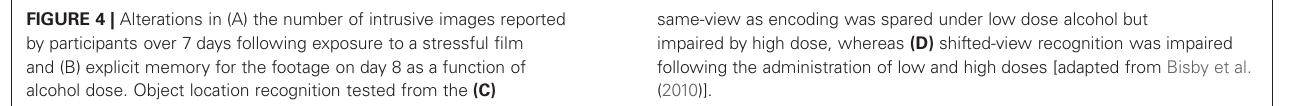
same-view as encoding was spared under low dose alcohol but impaired by high dose, whereas (D) shifted-view recognition was impaired following the administration of low and high doses [adapted from Bisby et al.